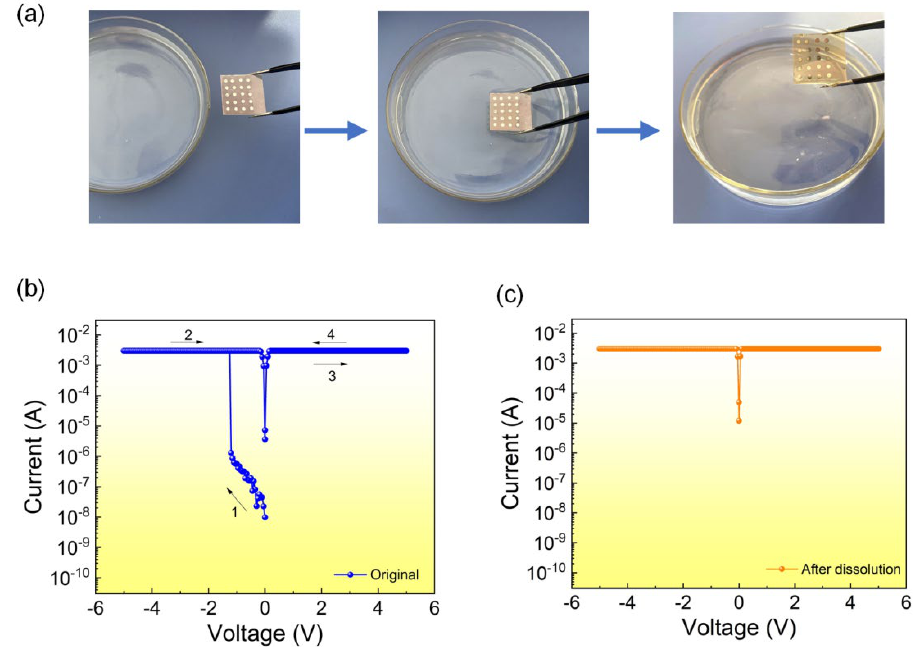
Figure 4. ( a ) The EA:Ag + films after dissolution in DI water. ( b , c ) The electrical properties of the original Al/EA:Ag+/ITO device and after dissolution.